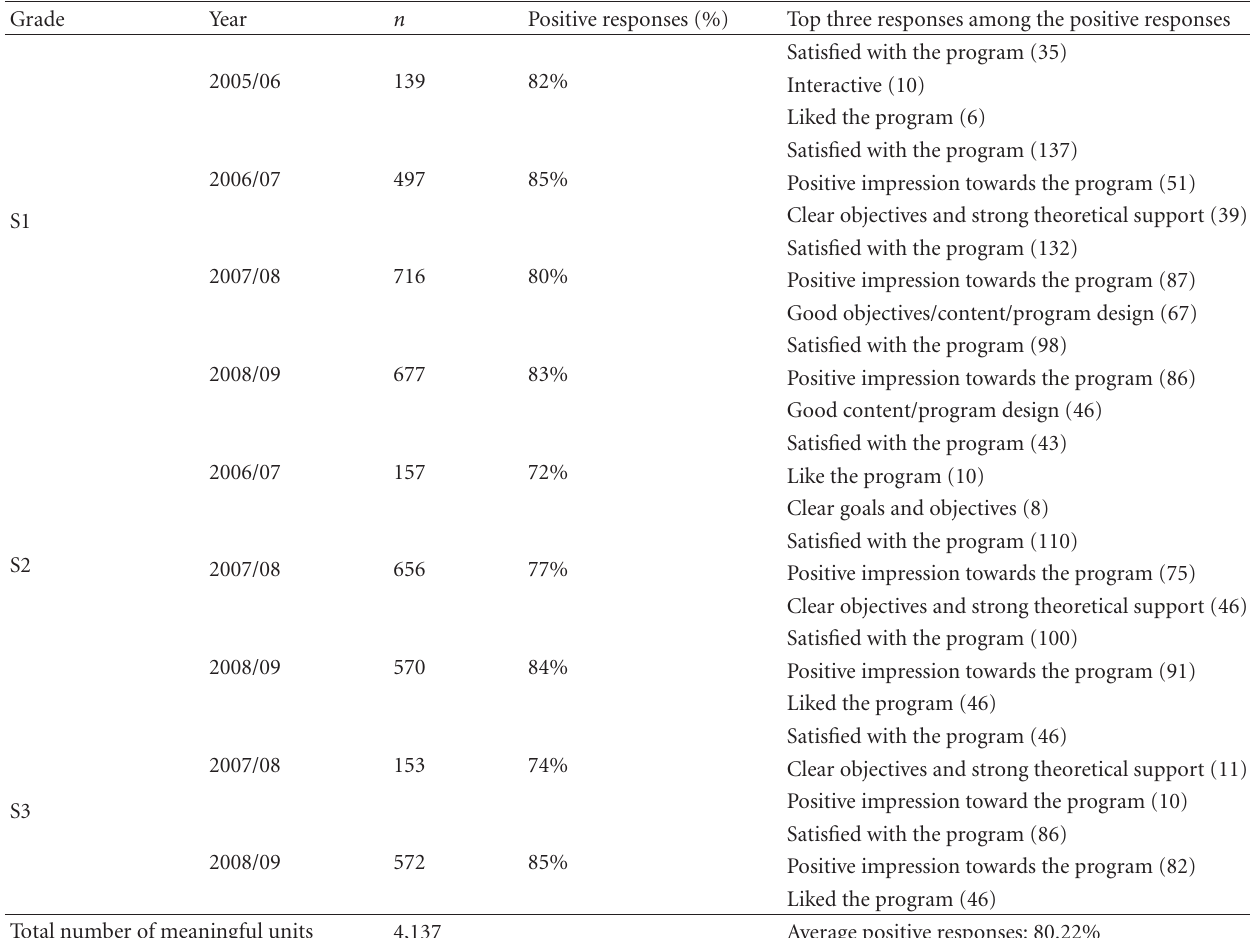
Table 2: Responses on views toward the program in di ff erent